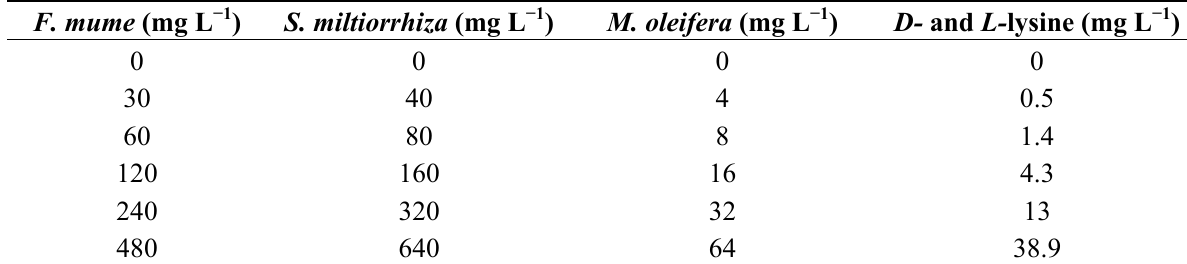
Table 1. Amounts of dried Fructus mume , Salvia miltiorrhiza and Moringa oleifera that were extracted in water and tested in different concentrations against Microcystis aeruginosa NIVA-CYA 43, including the concentration ranges for the amino-acids D - and L -lysine